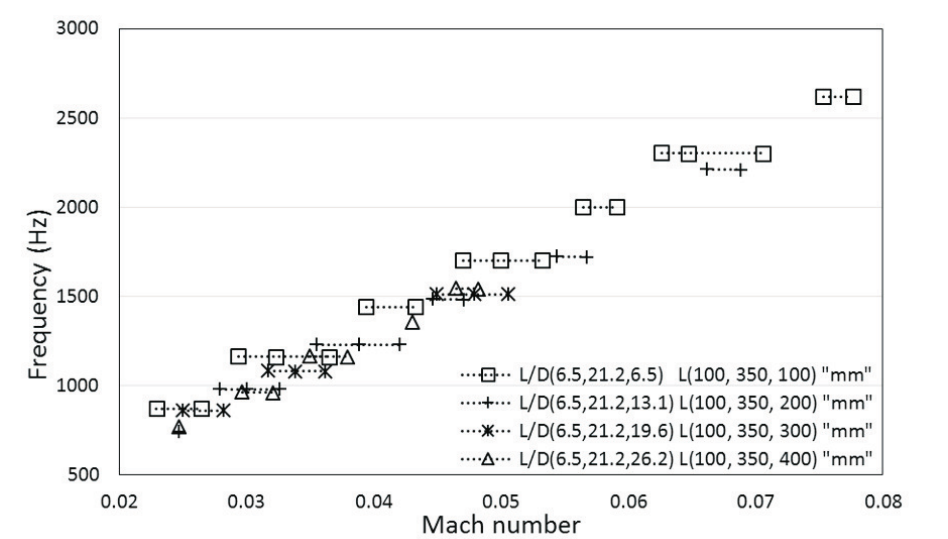
Figure 8. Frequency (Hz) plotted against Mach number M for L up = 100 mm, L corr = 350 mm, and L dw = 100–400